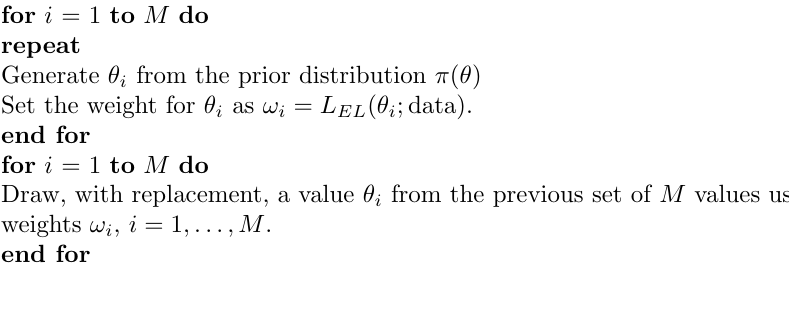
Algorithm 1: BC EL algorithm (Mengersen et al. ,